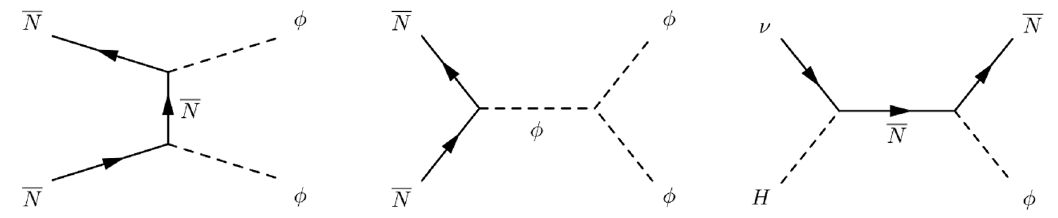
Figure 1 . The diagrams for φ -production processes. N , φ , H and ν denote the right-handed neutrino responsible for φ -production, the radial component of Φ , the SM SU(2) doublet Higgs and the active neutrino in the SM, respectively. In this paper, we consider the case where the first N - N t -channel scattering is the dominant one in φ